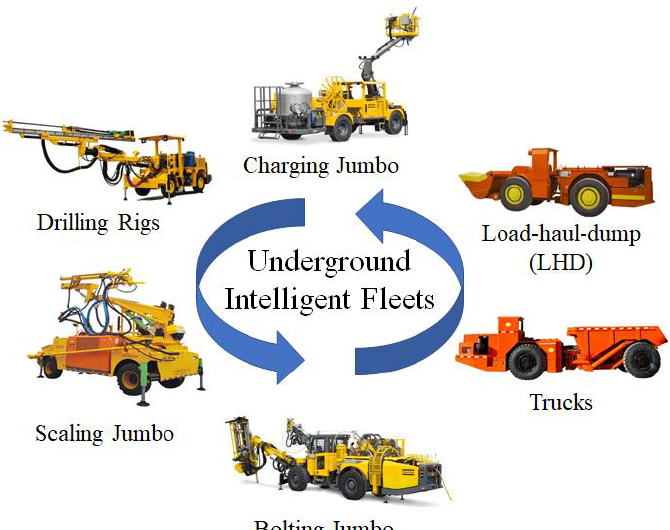
Figure 1. Underground intelligent vehicles.